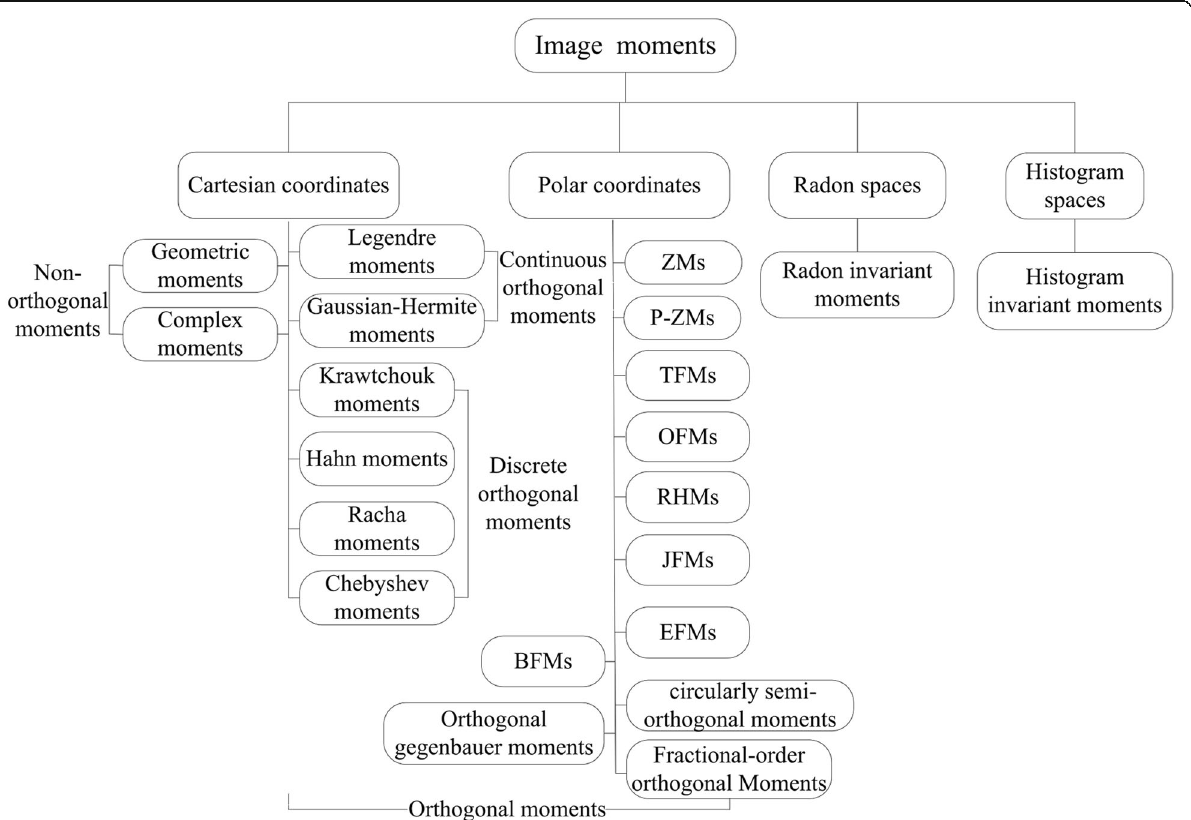
Fig. 1 Image moments in different coordinate